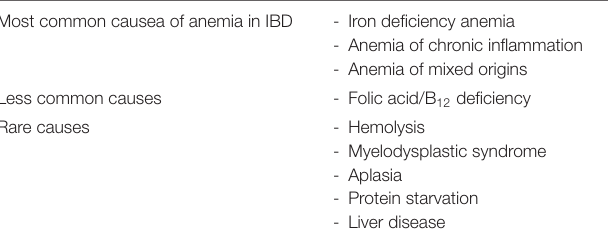
TABLE 2 | Ethiology of anemia in